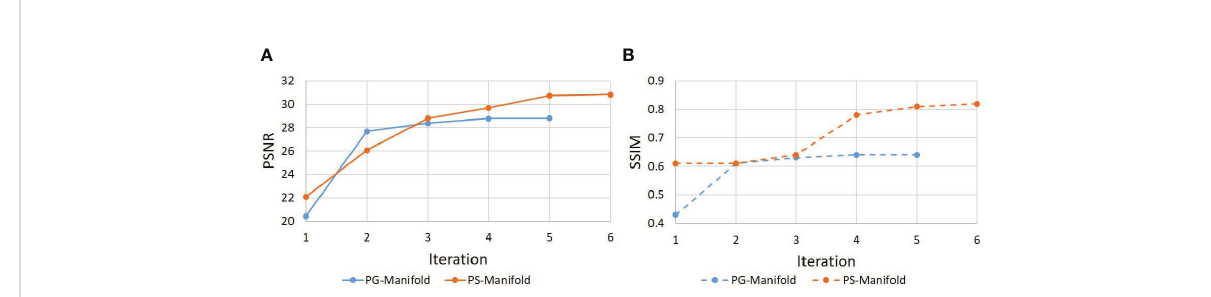
FIGURE 9 Evolution of (a) PSNR and (b) SSIM during the iterative reconstruction process for a real patient case.